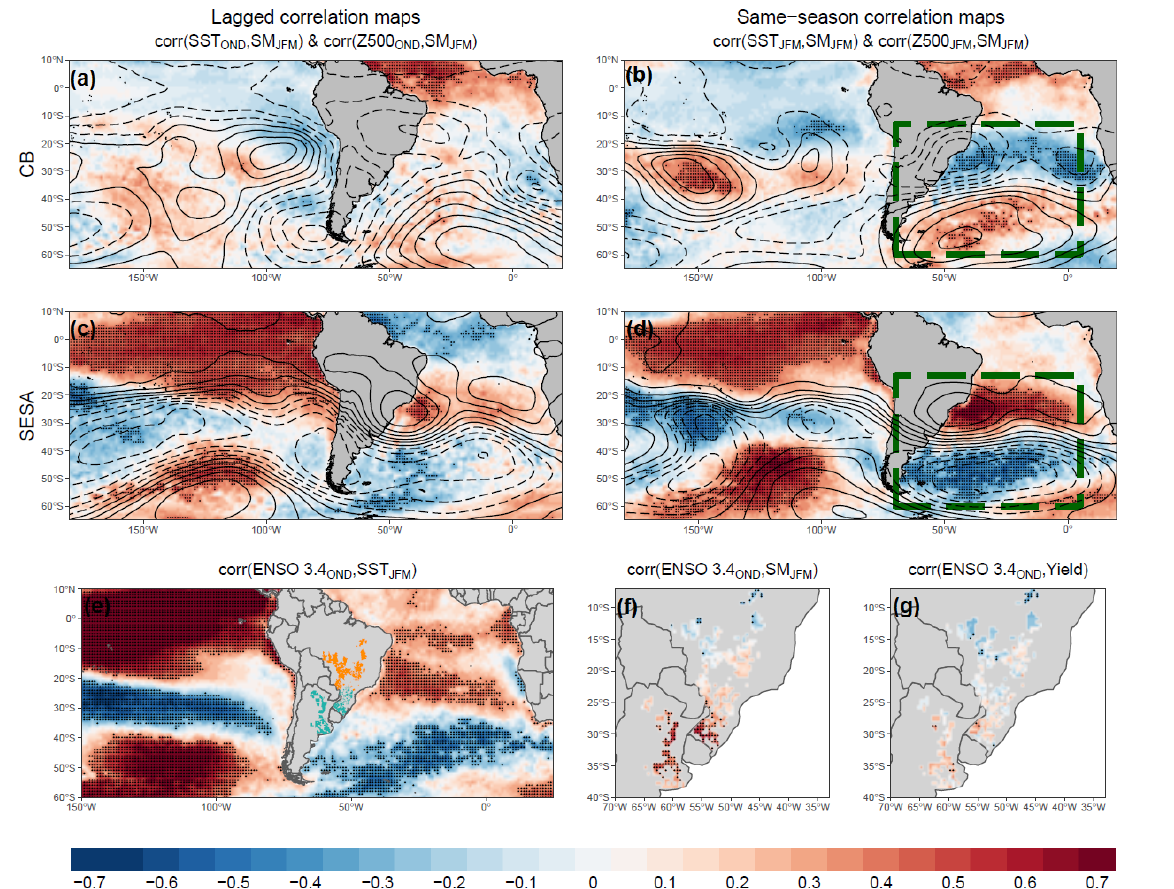
Figure 3. (a–d) Correlation maps at both lagged and same-season time steps for Z500 (contours) and SST (colors) against austral summer (JFM) soil moisture. Contour lines represent Z500 correlations with 0.1 increment, whereas negative values are dashed. (e–g) Correlation maps for lagged OND ENSO 3.4 index against austral summer SST (JFM), soil moisture (JFM) and yield anomaly in CB and SESA. Stippling indicates statistical significance ( P FDR < 0 . 05) after having corrected for false-discovery rate using the Benjamini–Hochberg correction. The green rectangles in (b) and (d) indicate the SST areas used to calculate the spatial covariance time